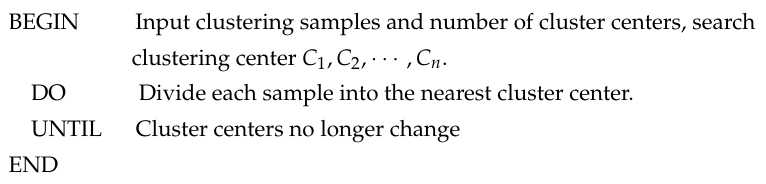
Table 3. Brief flow of K-means algorithm.